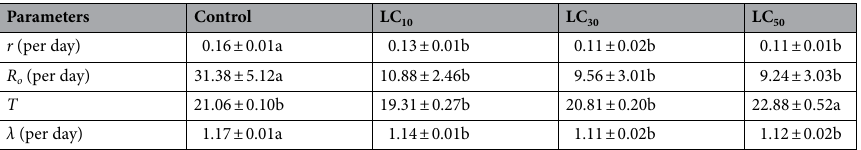
Table 3. Transgenerational effect of Lambda cyhalothrin on different life table parameters of Musca domestica. r = The intrinsic rate of increase (per day); ʎ = The finite rate of increase (per day); r = intrinsic rate of growth; R 0 = The net reproductive rate (offspring/individual); T = The mean generation time (days), λ = limiting rate of growth. Means in the same row followed by the same letter are not significantly different ( P > 0.05) using bootstrap